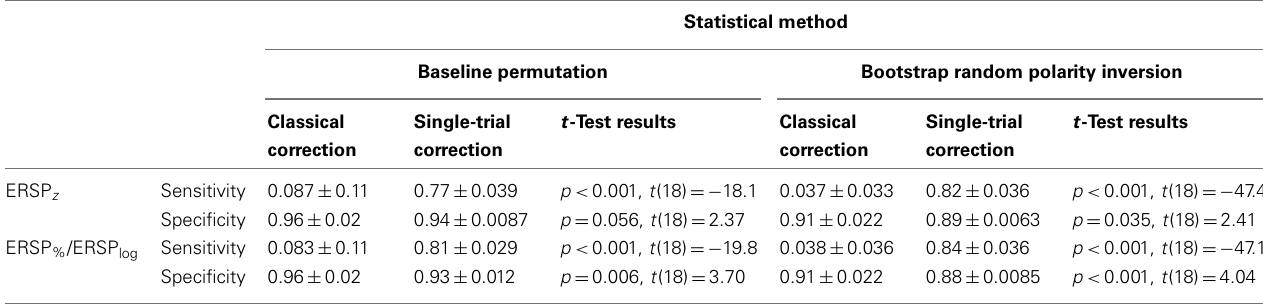
Table 1 | Sensitivity and specificity of the classical baseline correction and single-trial correction ERSP z and ERSP % /ERSP log methods for the two types of statistical methods when 8.6% of trials are